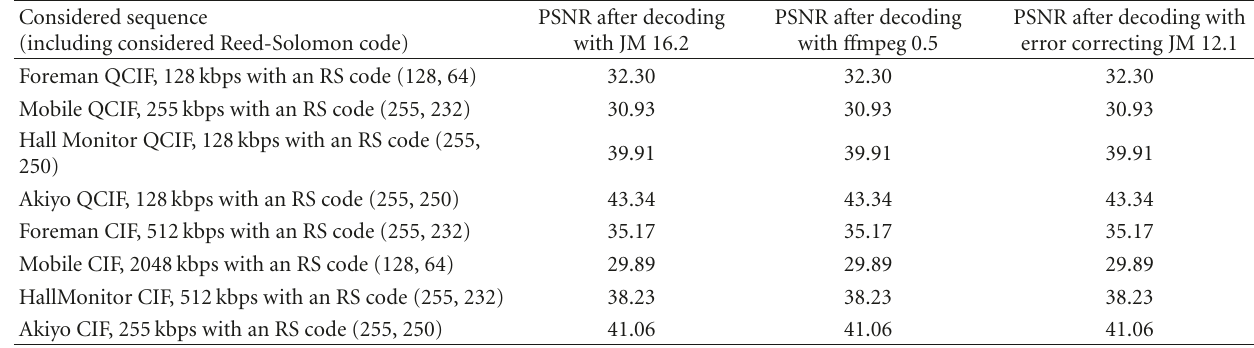
Figure 6: Simplified syntax of the supplementary NAL unit in case of 1/1 redundancy insertion. Table 1: Backward compatibility tests for H.264 redundancy enhanced